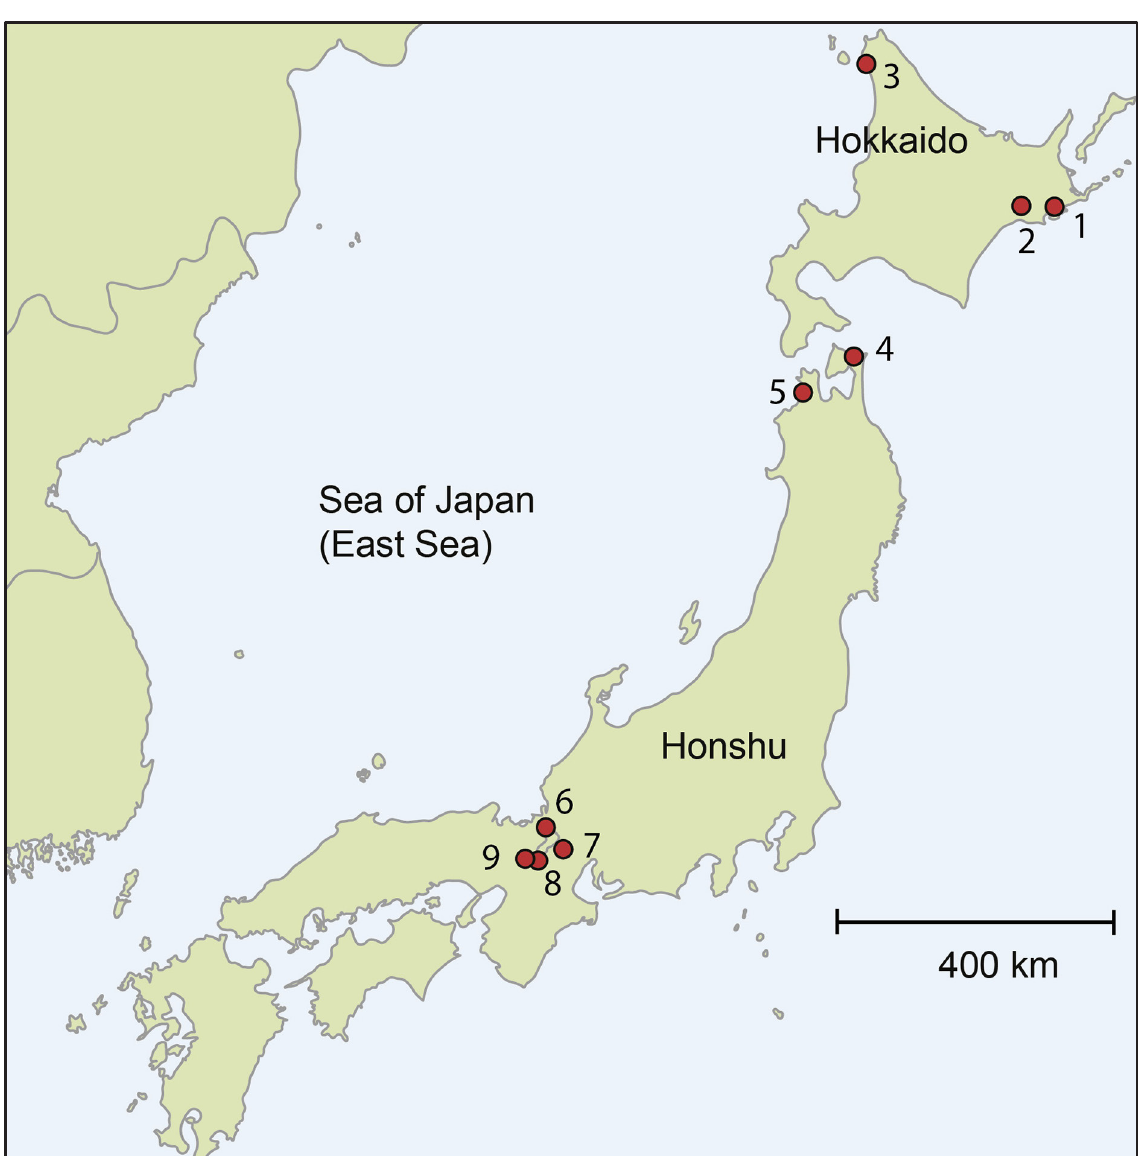
Fig. 1. Map of the main islands of Japan, showing the localities mentioned in the